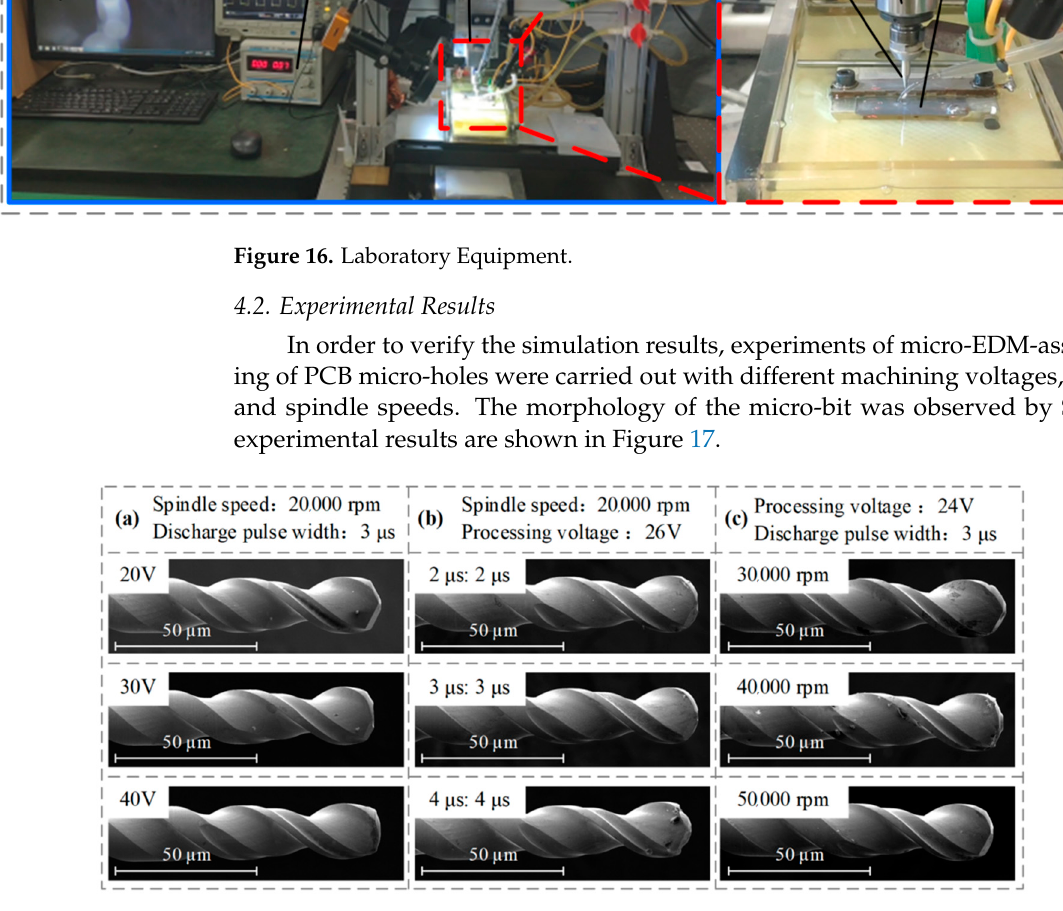
Figure 17. EDM wear of the micro-bit: ( a ) effects of machining voltages on the micro-bit wear; ( b ) effect of pulse widths on the micro-bit wear; ( c ) effect of spindle speeds on the micro-bit wear.